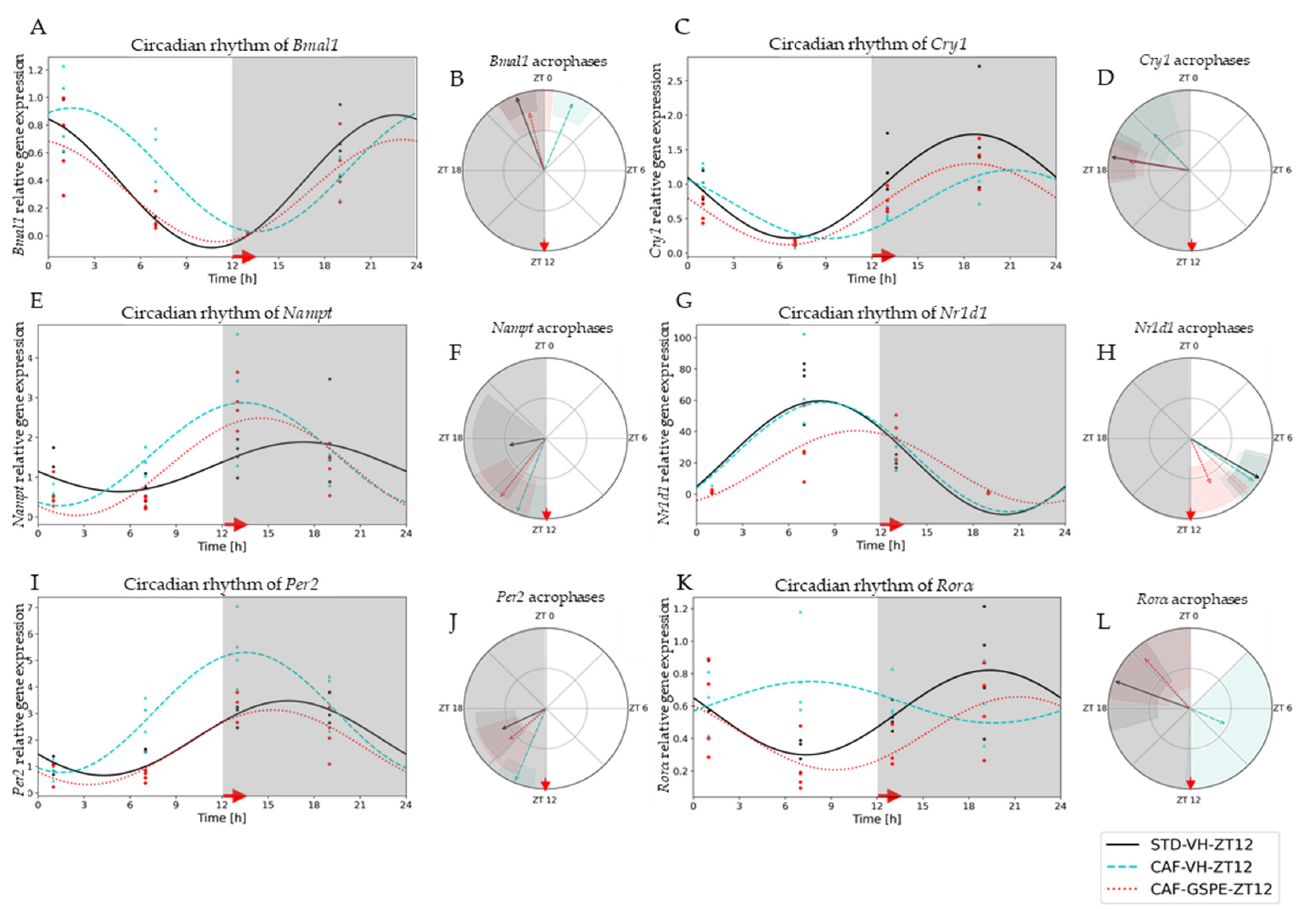
Figure 3. Estimated circadian rhythms (relative gene expression) of groups treated at night (ZT12). ( A ) Estimated circadian rhythms and ( B ) acrophases with their amplitudes represented of Bmal1 for ZT12-Vehicles and Treatments Groups (STD-VH, CAF-VH and CAF-GSPE). ( C ) Estimated circadian rhythms and ( D ) acrophases with their amplitudes represented of Cry1 for ZT12-Vehicles and Treatments Groups (STD-VH, CAF-VH and CAF-GSPE). ( E ) Estimated circadian rhythms and ( F ) acrophases with their amplitudes represented of Nampt for ZT12-Vehicles and Treatments Groups (STD-VH, CAF-VH and CAF-GSPE). ( G ) Estimated circadian rhythms and ( H ) acrophases with their amplitudes represented of Nr1d1 for ZT12-Vehicles and Treatments Groups (STD-VH, CAF-VH and CAF-GSPE). ( I ) Estimated circadian rhythms and ( J ) acrophases with their amplitudes represented of Per2 for ZT12-Vehicles and Treatments Groups (STD-VH, CAF-VH and CAF-GSPE). ( K ) Estimated circadian rhythms and ( L ) acrophases with their amplitudes represented of Ror α for ZT12-Vehicles and Treatments Groups (STD-VH, CAF-VH and CAF-GSPE).